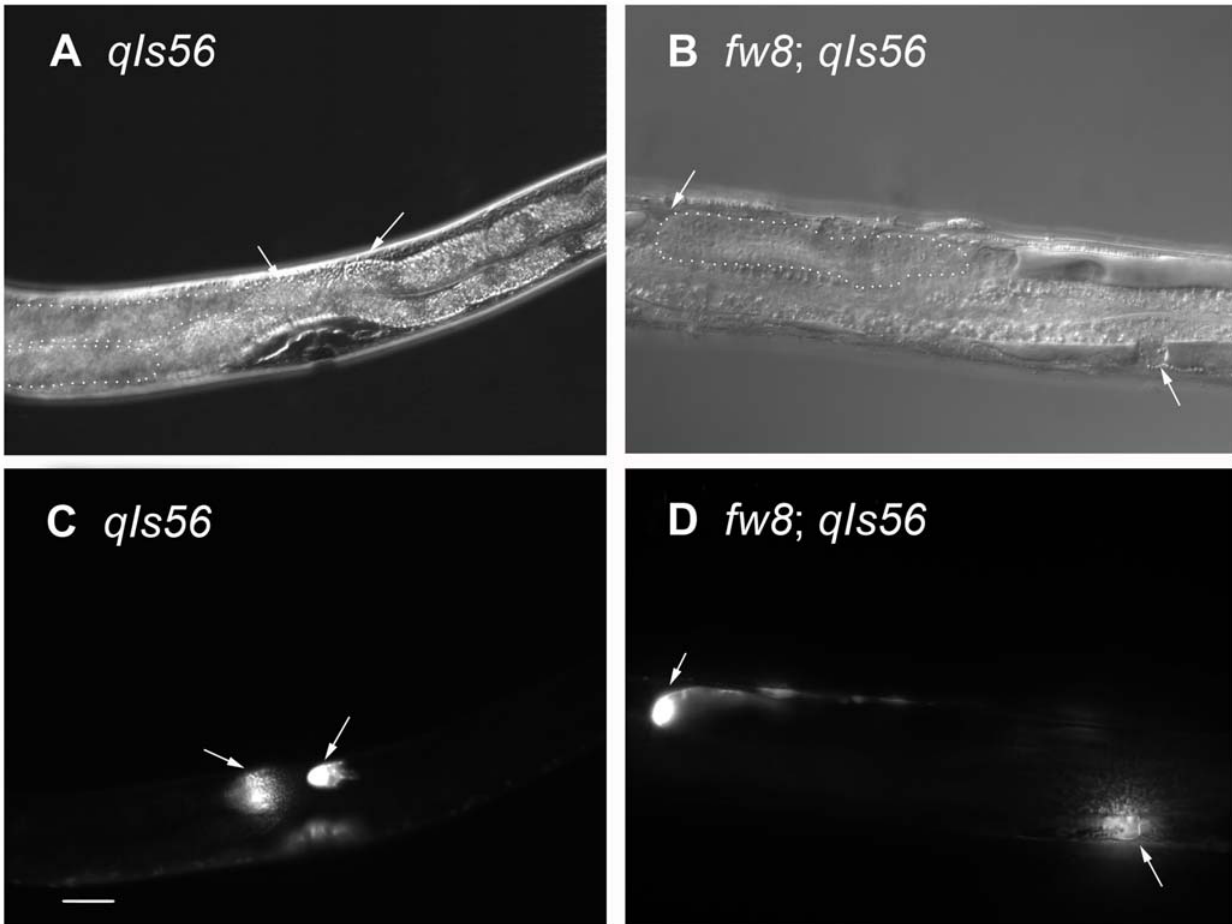
Figure 7. Nomarski and DTC Marked GFP ( qIs56 ) Images of bub-1 Mutants. (A) The DIC and (C) the DTC GFP picture of the same N2. (B) The DIC and (D) the DTC GFP picture of the same bub-1 ( fw8 ) mutant. The DTC GFP cells showed that the bub-1 ( fw8 ) mutant gonad arm could not grow to form the U shape gonad. Anterior is to the left and ventral side is down. One gonad in each animal in (A) and (B) was outlined in a dotted line. Dorsal is up in 7a and 7c; and dorsal is facing out the paper in 7b and 7d. The scale bar represents 25 m